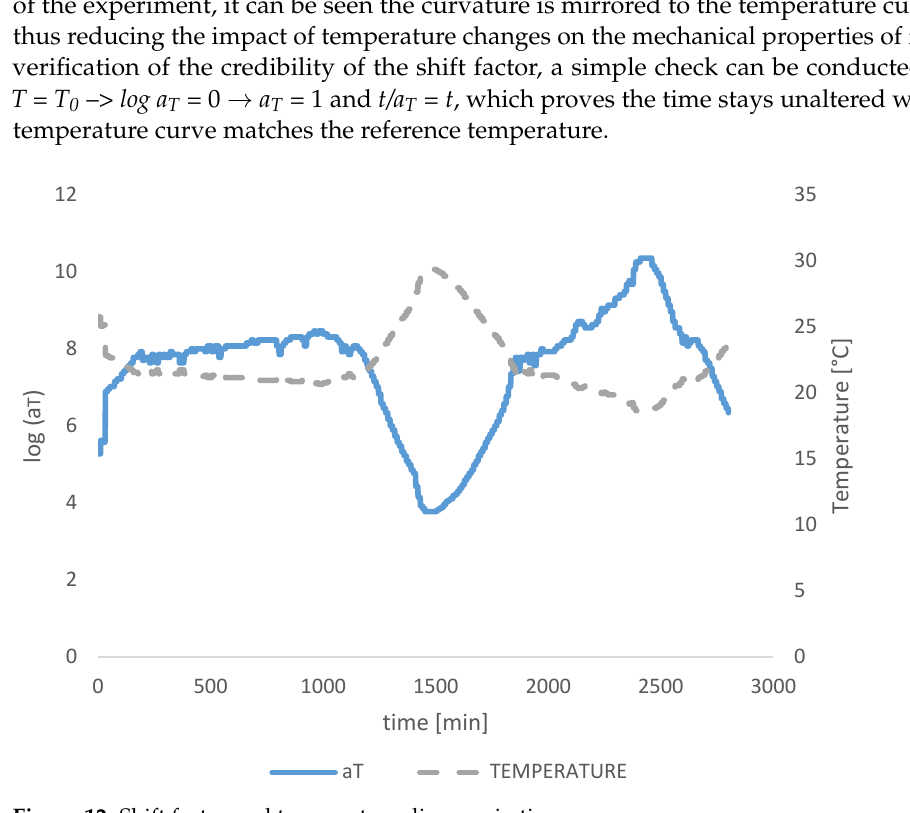
Figure 12. Shift factor and temperature diagram in time.